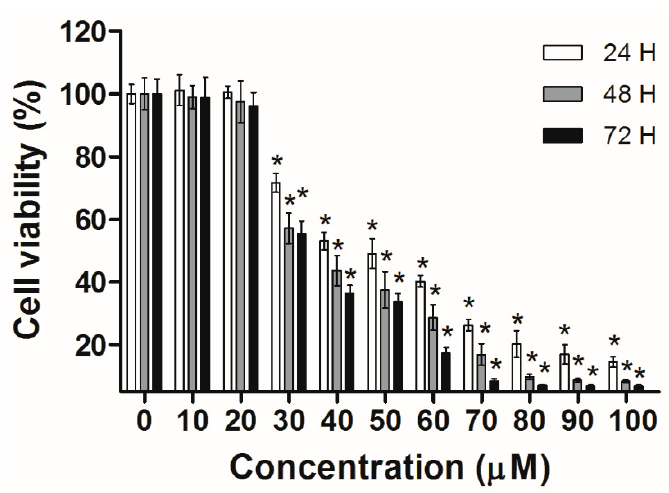
Figure 2. Cell viability of Huh-7 cells exposed to increasing doses of UA. The cells were seeded in plates, then treated with various doses of UA. The cell viability was assessed using the MTT. The results were presented as means ± S.D. * p < 0.05; compared with the untreated controls.